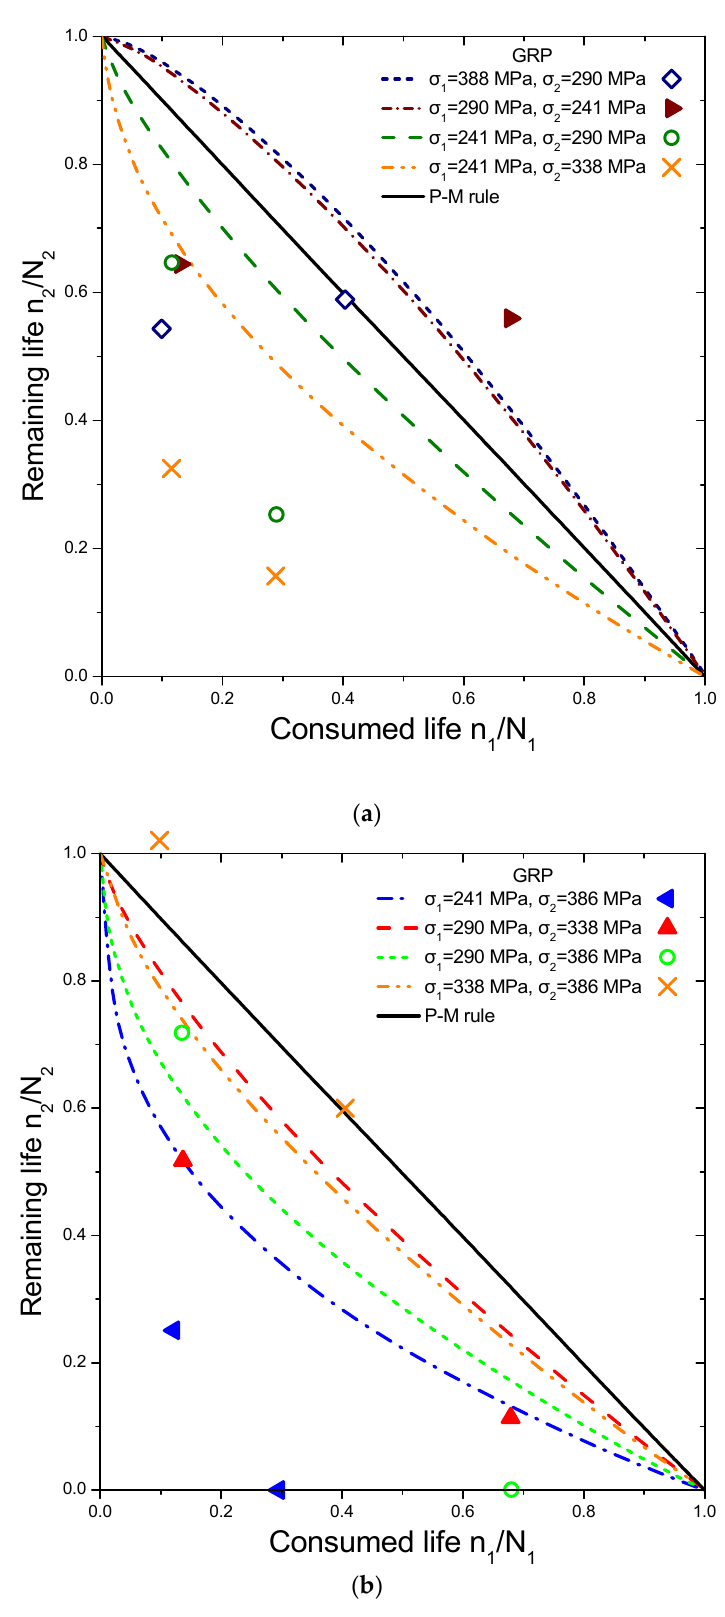
Figure 4. ( a , b ) Analytical prediction of the remaining life versus consumed life for the case of glass/epoxy (GRP). The experimental data points are taken from Ref [44].